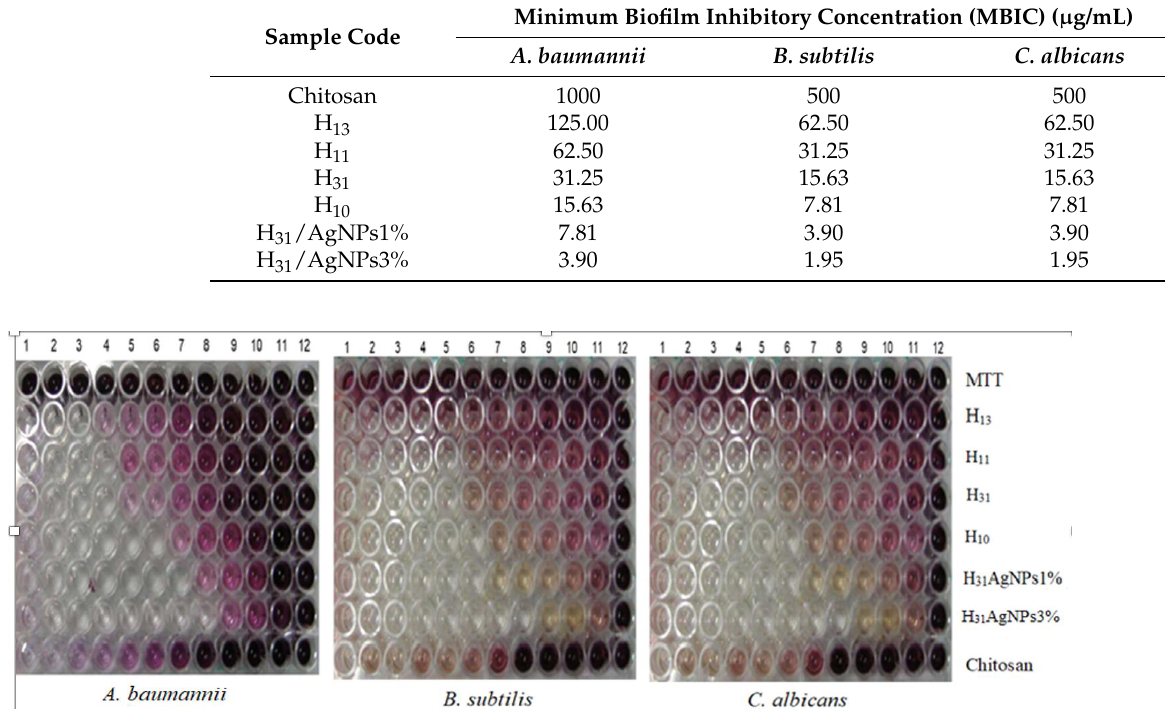
Table 2. Minimum inhibitory concentration of chitosan, H 10 , H 13 , H 11 , H 31 , H 31 /AgNPs1%, and